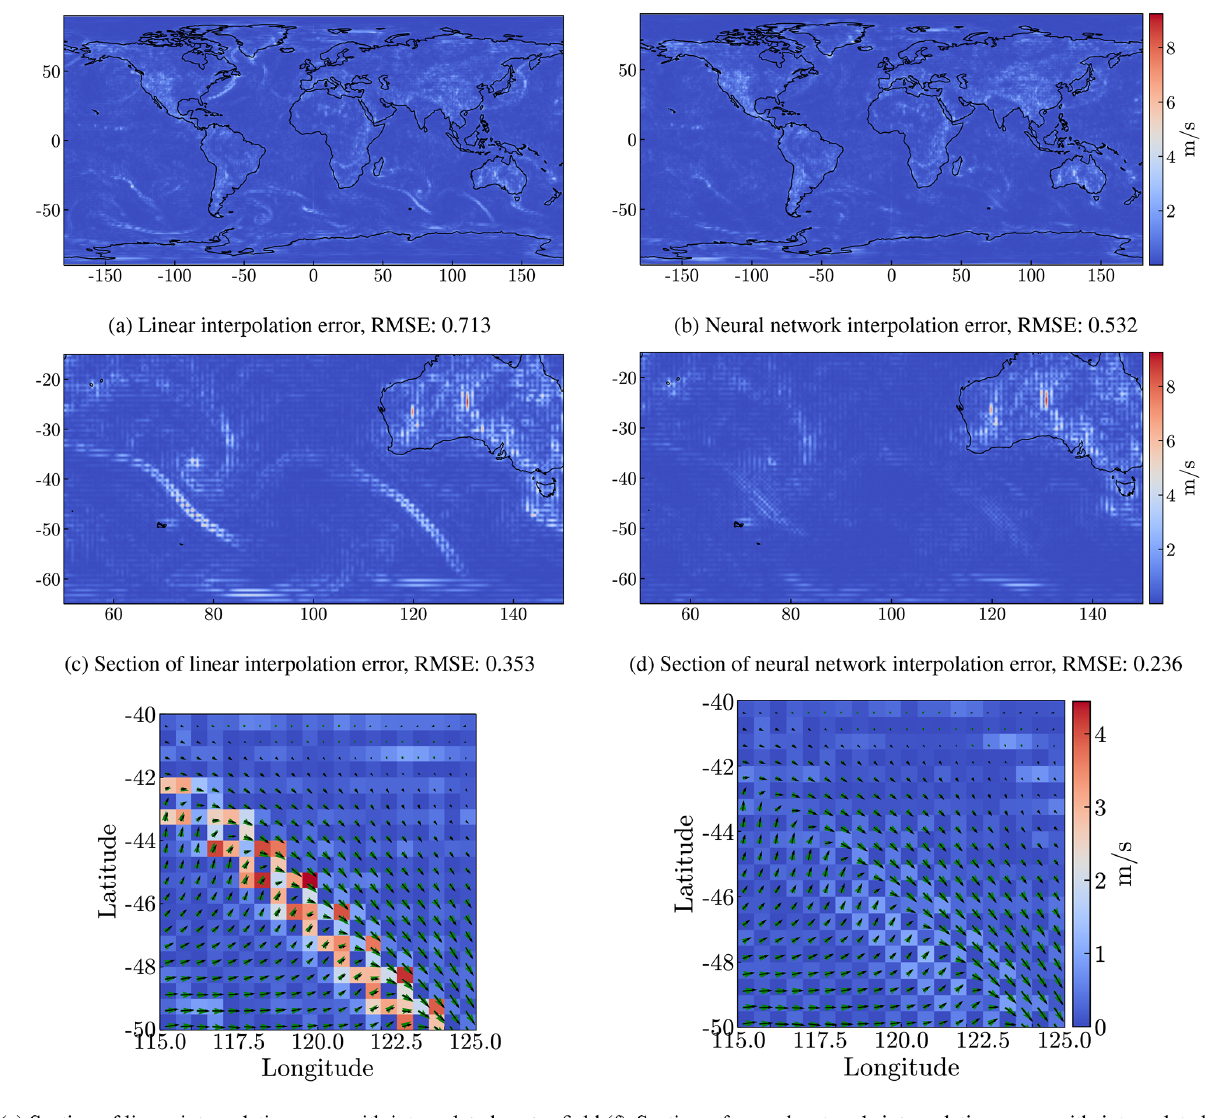
Figure 3. Differences between the v = (u,v) fields on the 14 January 2000 at 10:00UTC for level 10 (around 245m) and the truth ERA5 data, for linear interpolation (a, c, e) and for the interpolation by the model2 neural network (b, d, f) . The data are interpolated from degraded 1 ◦ × 1 ◦ resolution data. The top row (a, b) shows the error on the globe and the panels below show an enlarged section of the top